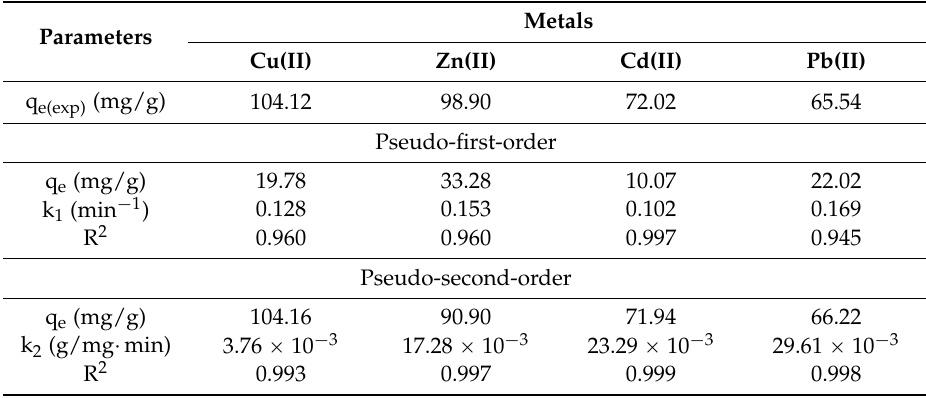
Table 2. Kinetics of heavy metals removal onto SiNTh-Py (at pH = 6, V = 10 mL, m = 10 mg of SiNTh-Py and optimum concentration: 140 mg/L in each case).